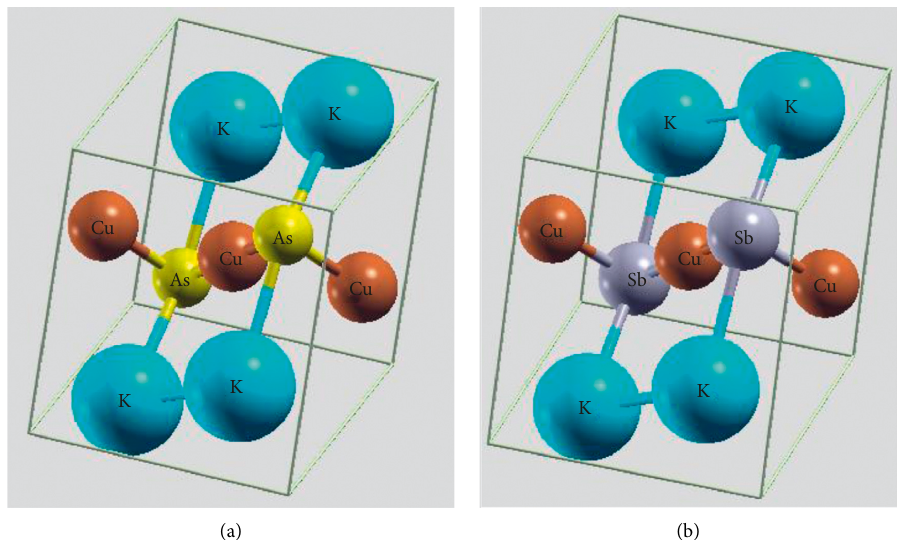
Figure 1: The orthorhombic crystal structures of (a) K